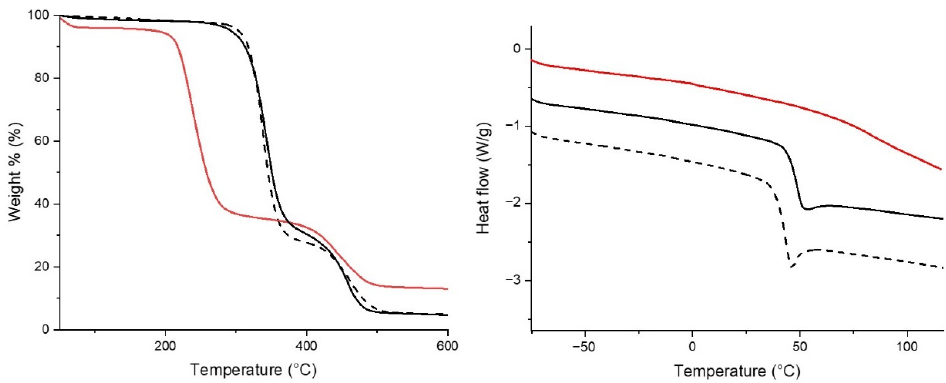
Figure 4. TGA ( left ) and DSC traces ( right ) of PVAc (black dashed line), CoVAc-VA (black continuous line), and PVA (red continuous line).